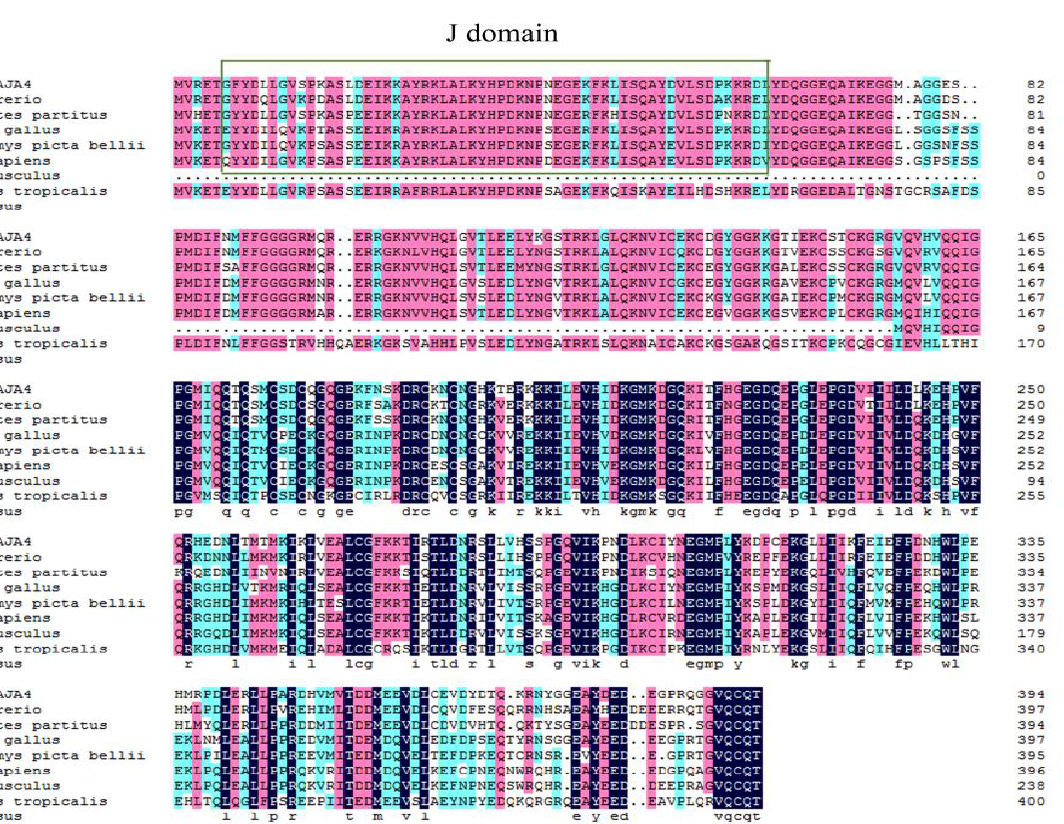
Figure 1. Amino acid alignment of DNAJA4s from different species. The conserved domains (aa 0–70), respectively. The accession numbers were listed as follows: Epinephelus coioides, MN937271; Danio rerio, XP_002666797.3; Stegastes partitus, XP_008275021.1; Gallus gallus, XP_413746.5; Chrysemys picta bellii, XP_005294547.1; Homo sapiens, AIC63476.1; Mus musculus, AAH22948.1; Xenopus tropicalis.